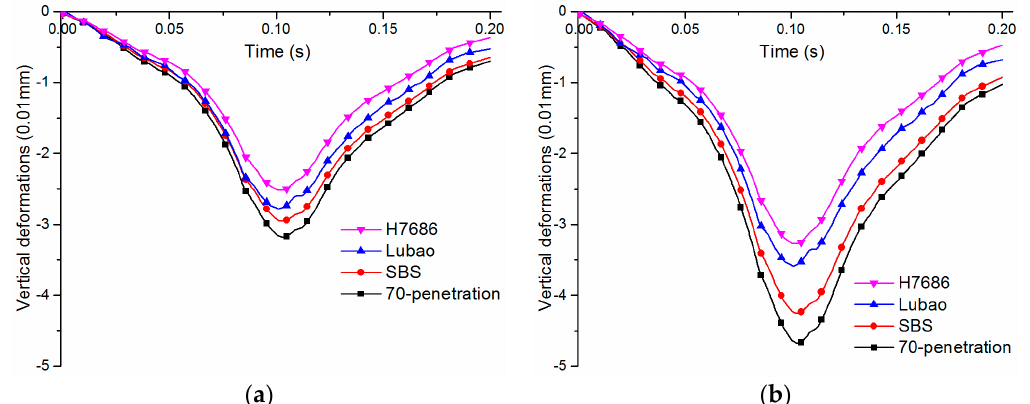
Figure 6. Vertical deformations at centers of road surface: ( a ) under standard load; ( b ) under heavy load.